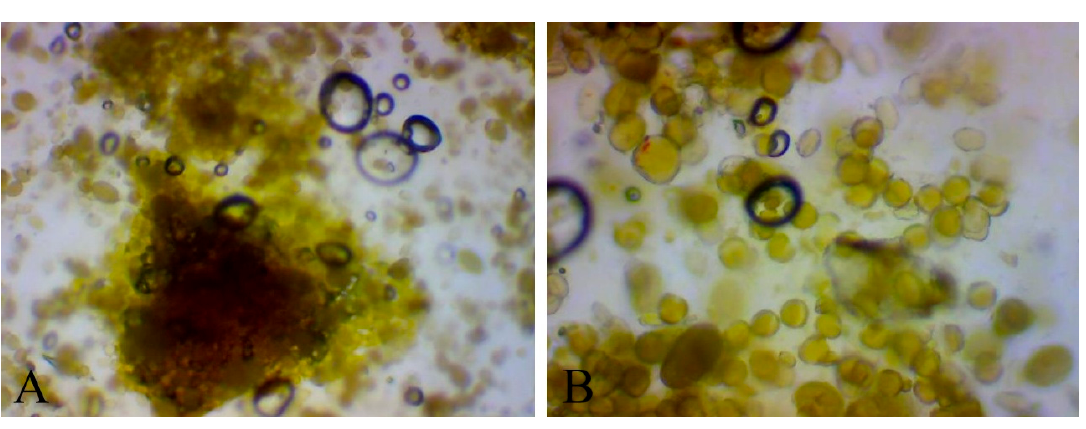
Figure 3. Microscopic images of beebread caviar just after preparation: ( A )—4× magnification, ( B )—10× magnification . Molecules 2020 , 25 , 4483